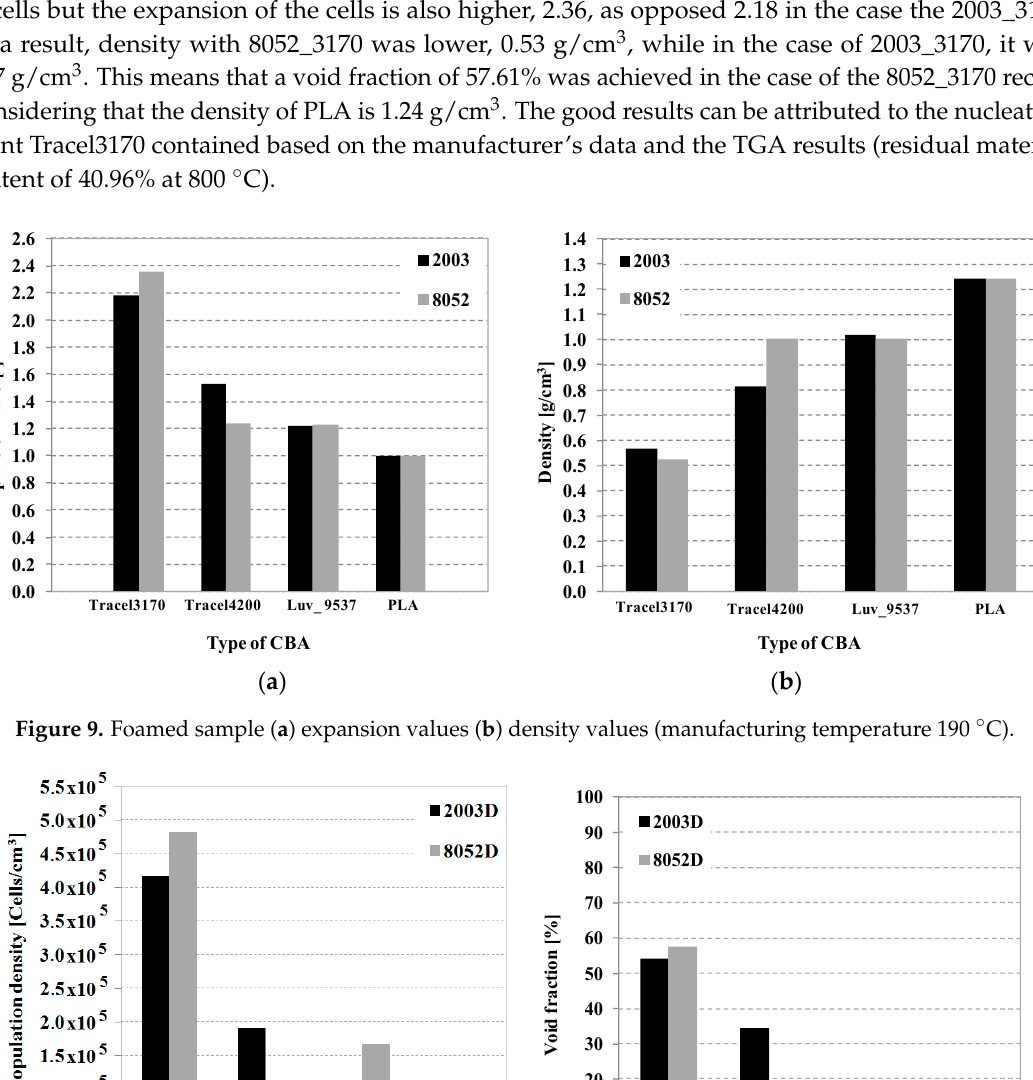
Figure 10. ( a ) Cell population density and ( b ) porosity in the case of the different foaming agent types (manufacturing temperature 190 °C).